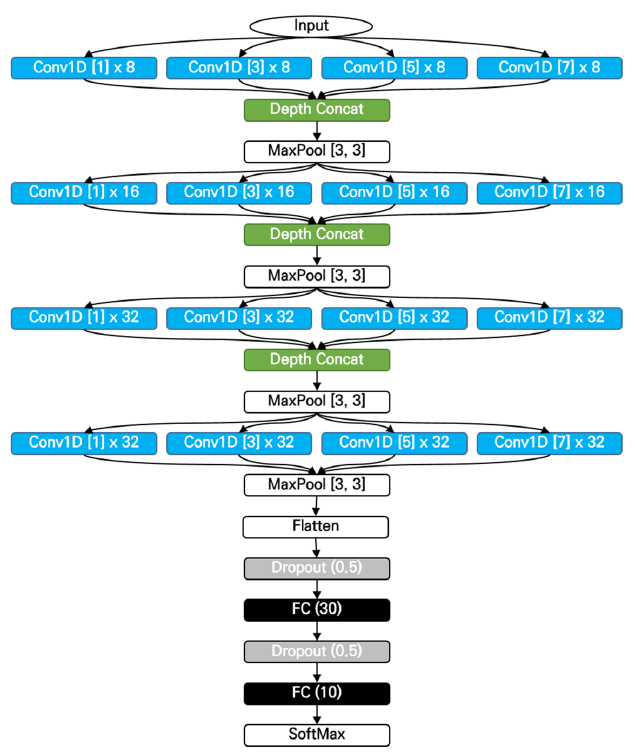
Figure 4. Proposed network structure.